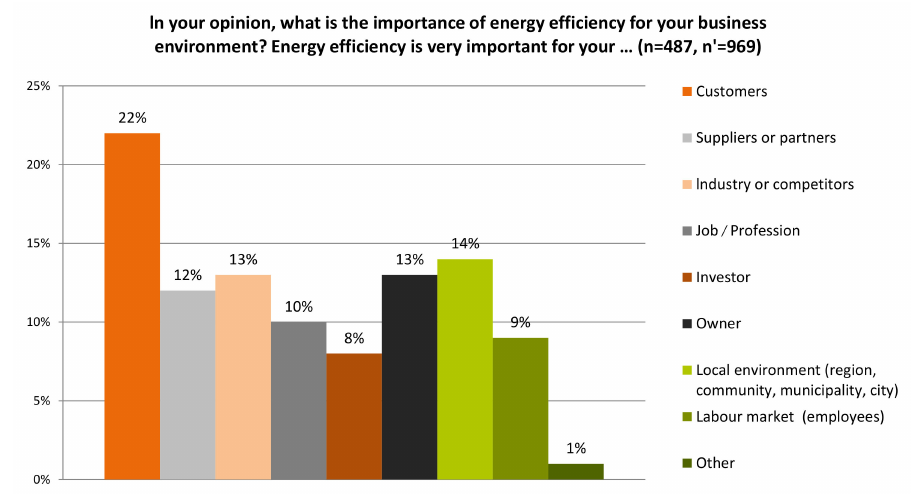
Figure 10. The perception of the importance of energy e ffi ciency for the environment of the